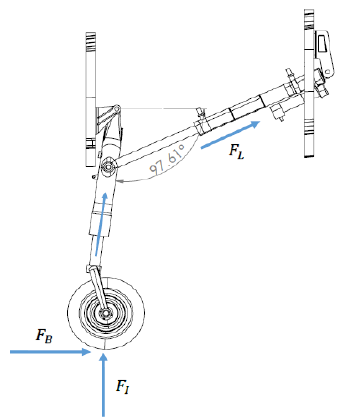
Figure 9. Forces acting on nose landing gear strut. Impact force ( F I ), Braking force ( F B ), Axial force ( F L ) acted on actuator at